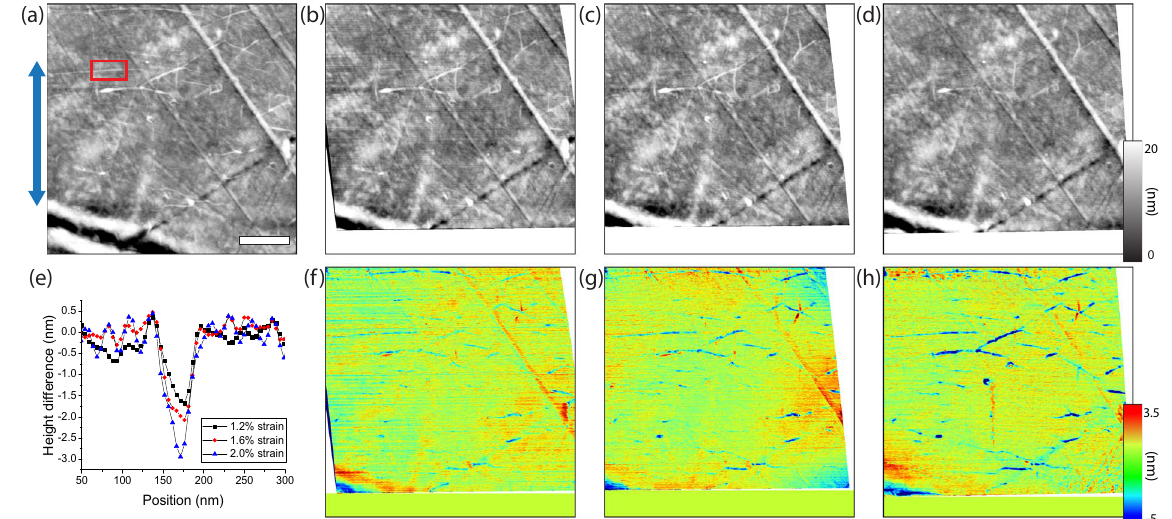
Figure 4. CVD graphene on polyethylene terephthalate imaged at different tensile strains. The AFM topographies ( a – d ) at nominal strains of 0%, 1.2%, 1.6% and 2%, respectively, show the progressive disappearance of wrinkles as the bending strain is increased in the direction of the blue arrow. Thanks to the distortion correction, the differential height images ( f – h ) between the height images at 0% and 1.2%, 1.6% and 2% strain, respectively, demonstrate the disappearance (blue features) of wrinkles perpendicular to the strain direction (red arrow) whereas the remaining area shows little height difference (green-yellow region). The average height differential of the wrinkle highlighted in ( a ) is shown in ( e ), demonstrating a decrease in height as a function of